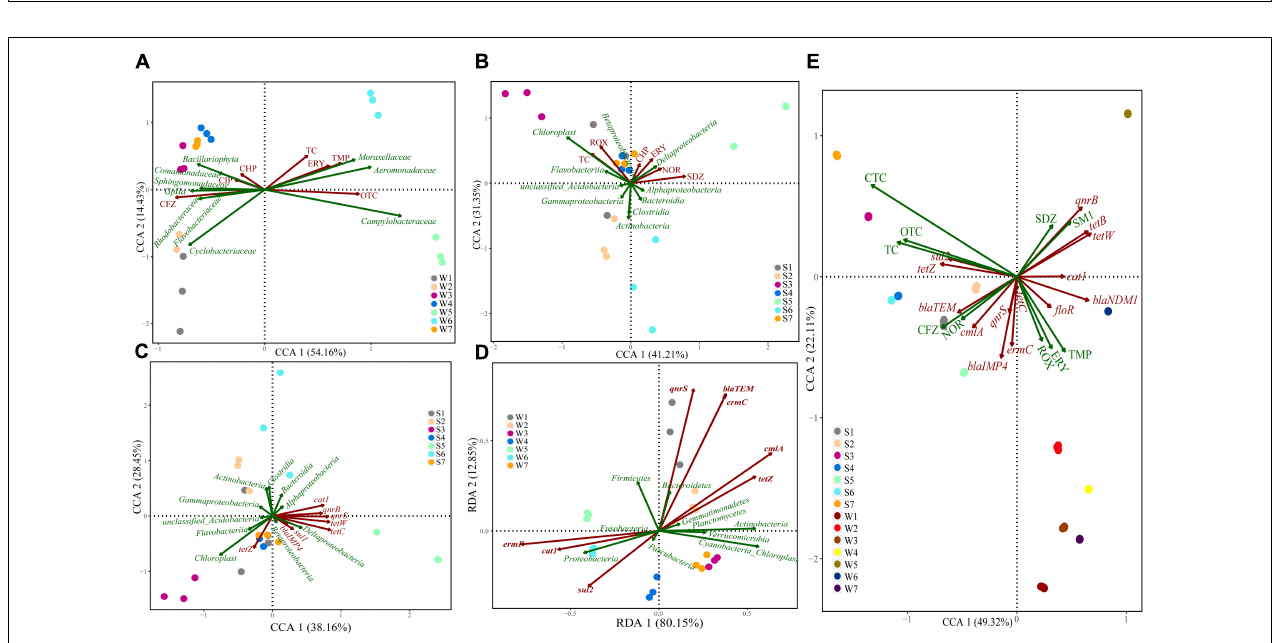
FIGURE 5 | Concentration of antibiotics in water (A) and sediment (B) samples.